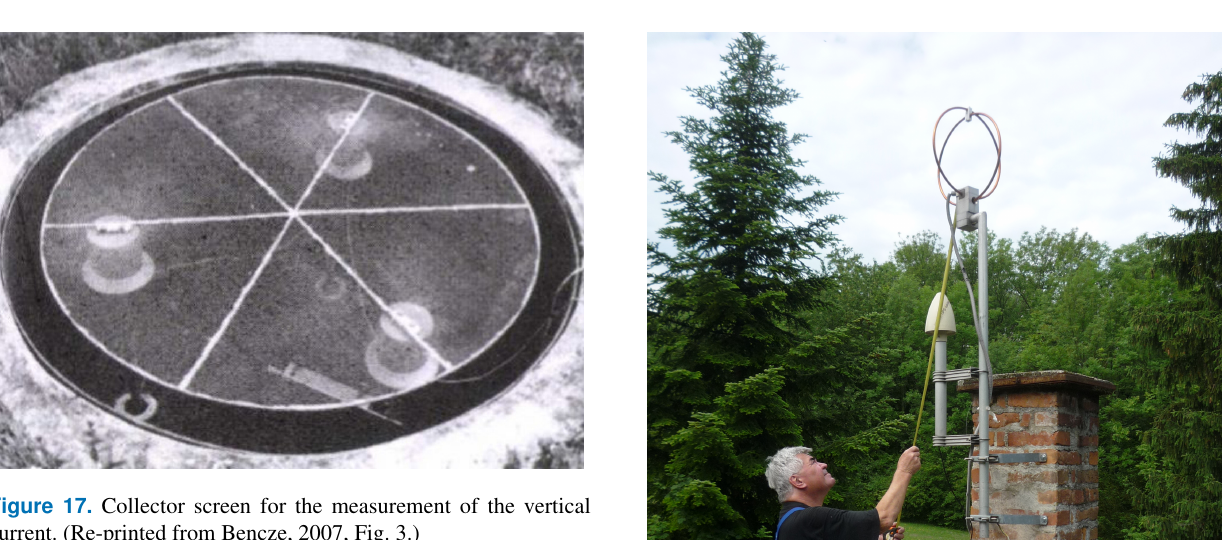
Figure 16. (a) The transmitter antenna of the DPS-4D Digisonde at NCK and (b) one of the first ionograms detected by the system.